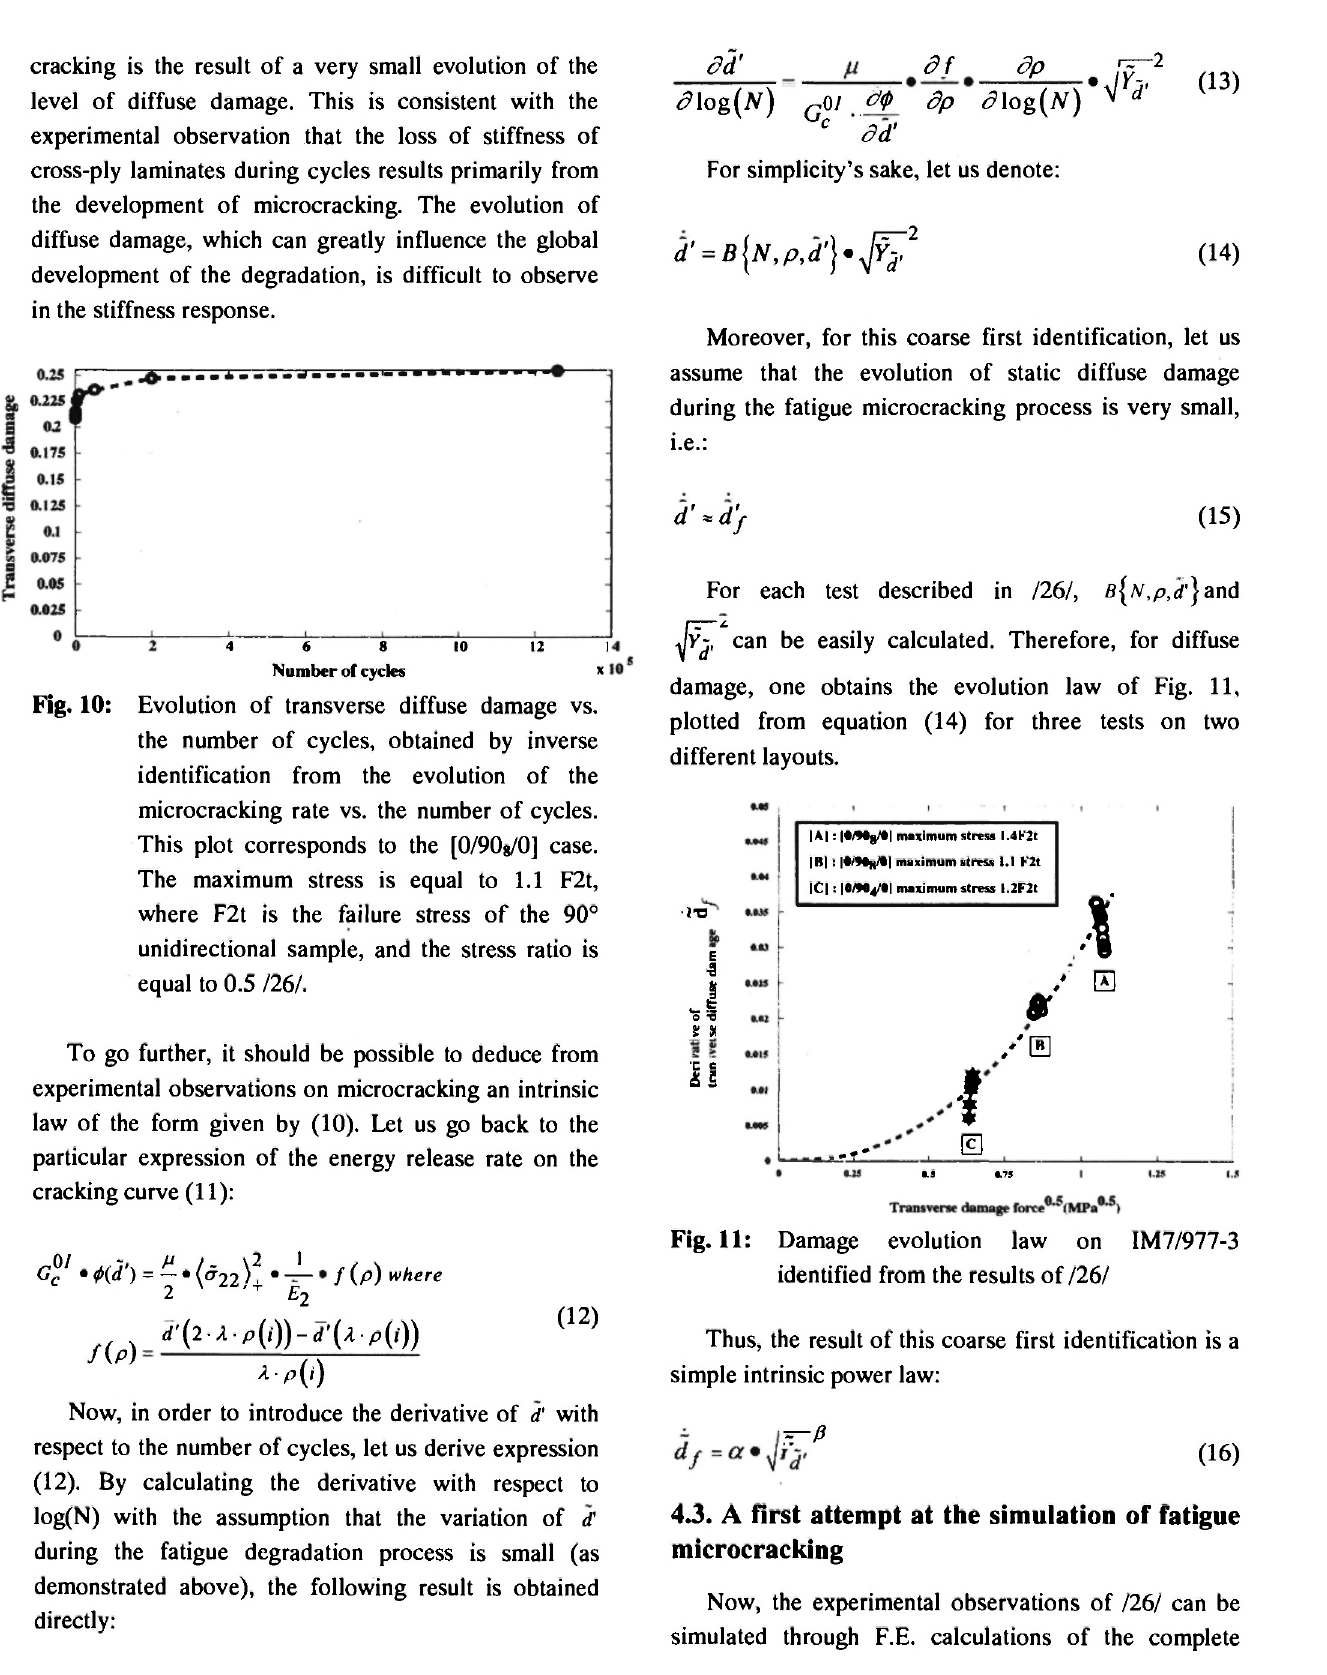
Fig. 11: Damage evolution law on IM7/977 identified from the results of /26/